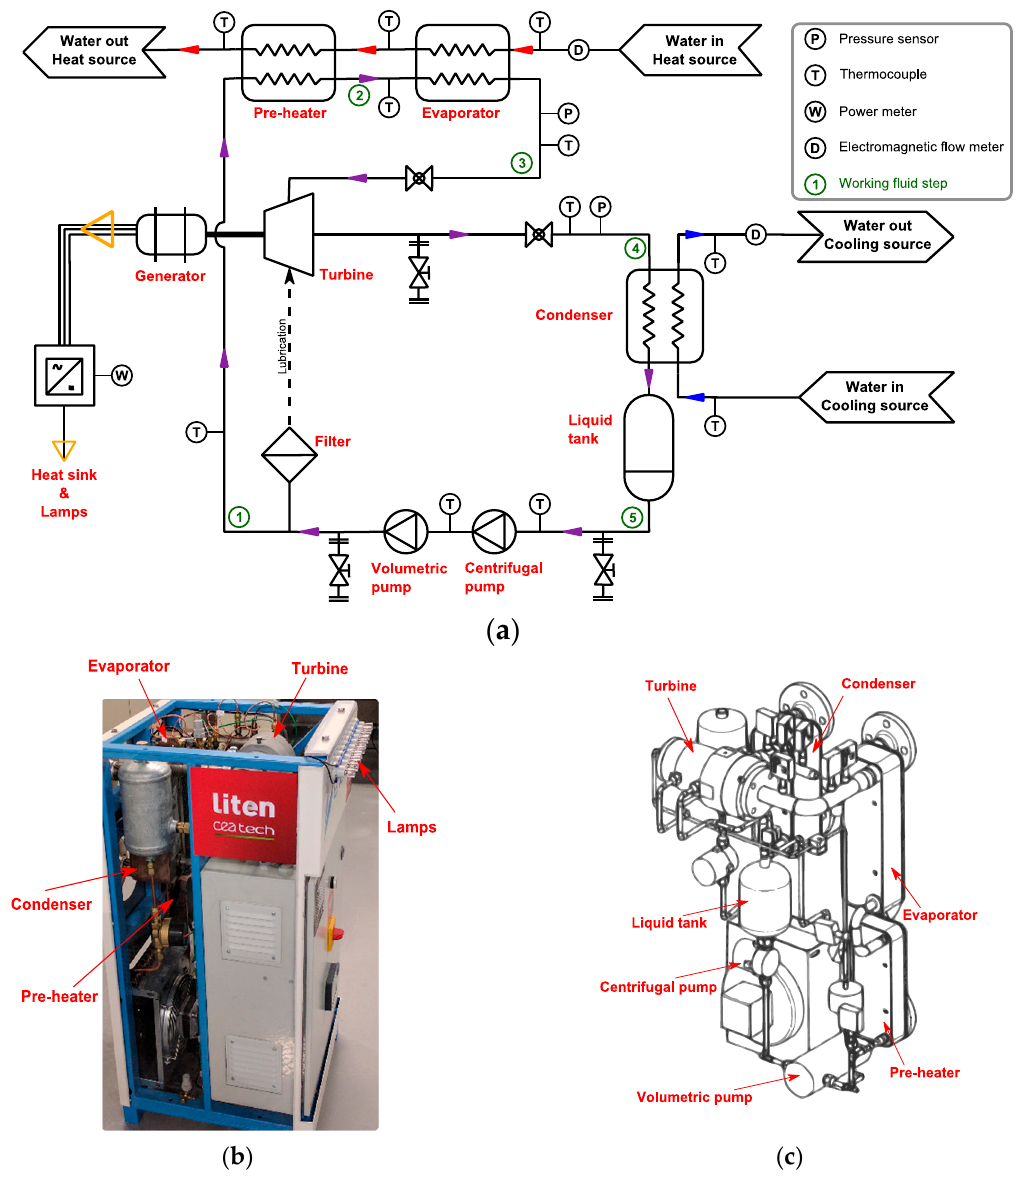
Figure 1. The Experimental Organic Rankine Cycle ( a ) Process Flow Diagram (PFD); ( b ) Picture; ( c ) Diagram.